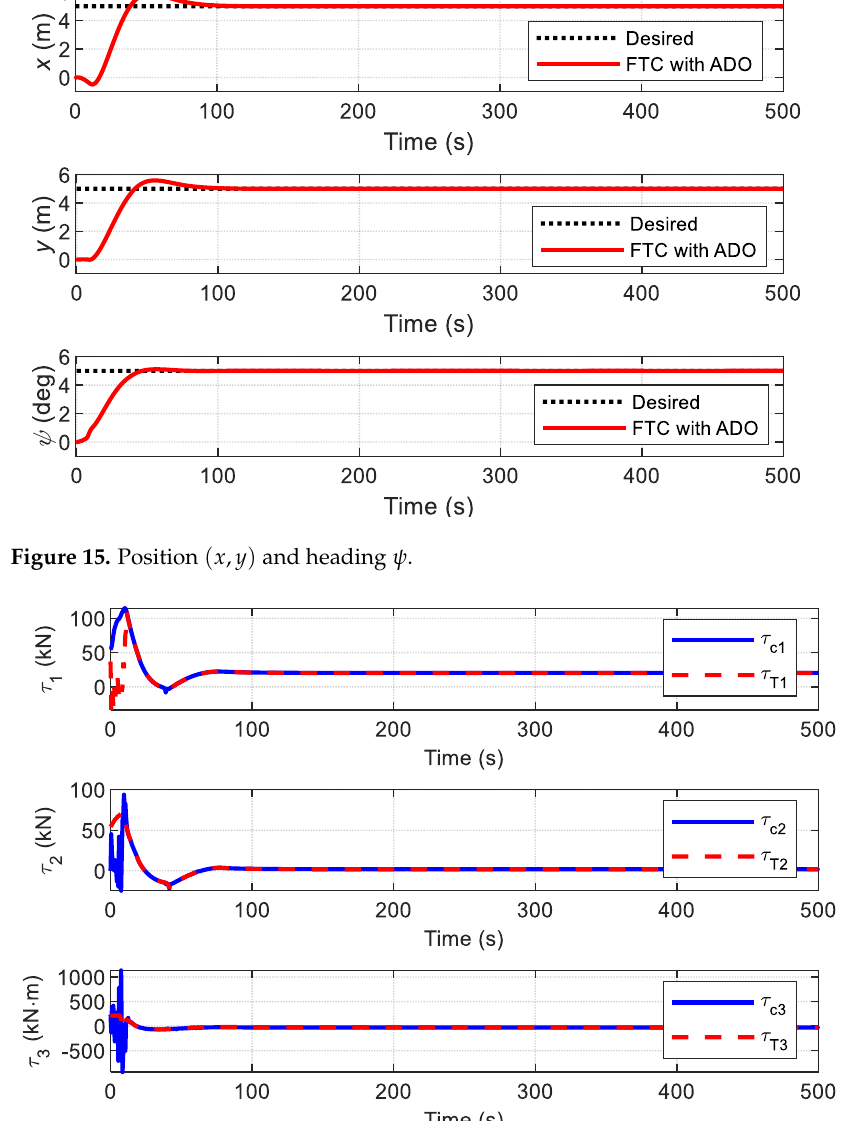
Figure 17. The forces of each thruster. Case 2: FTC with ADO and ADS The performance of the proposed FTC with ADO and ADS is evaluated, where the ADS is applied to deal with the actuator constraints, and its design parameter is selected as diag(0.58,0.45,0.25) K χ